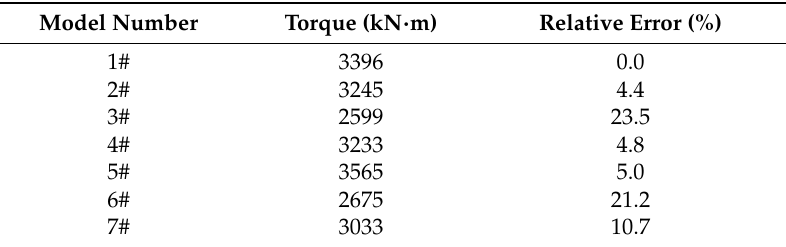
Table 4. Load torque of each model and relative error.